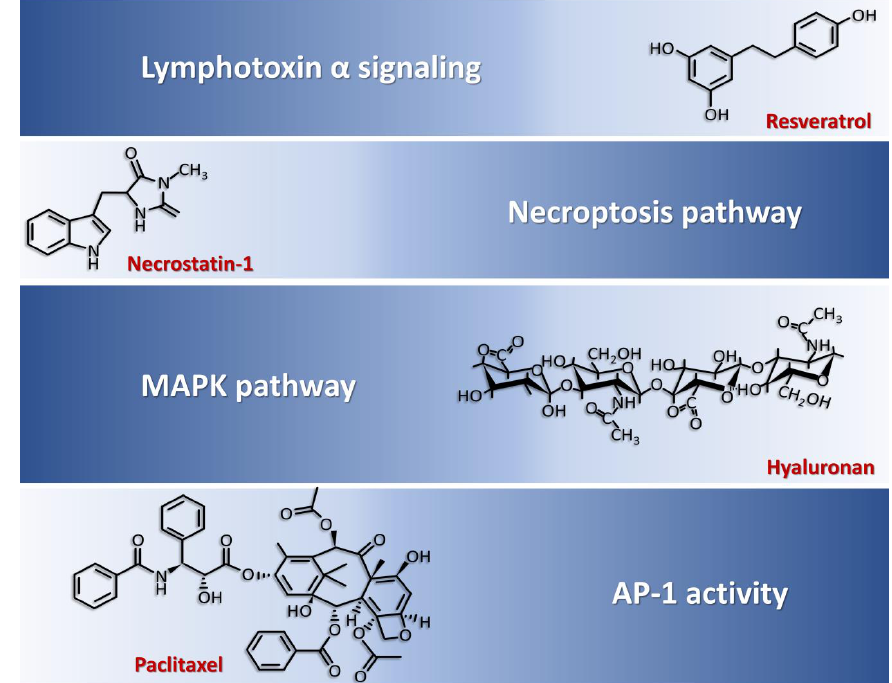
Figure 2. Inhibitors of chondrocytes dysfunction and corresponding targeting pathways. Resveratrol interferes with lymphotoxin α signaling, necrostatin-1 inhibits necroptosis pathway, hyaluronan blocks MAPK pathway, and paclitaxel suppresses AP-1 activity which contribute to chondrocyte dysfunction in rheumatoid arthritis.